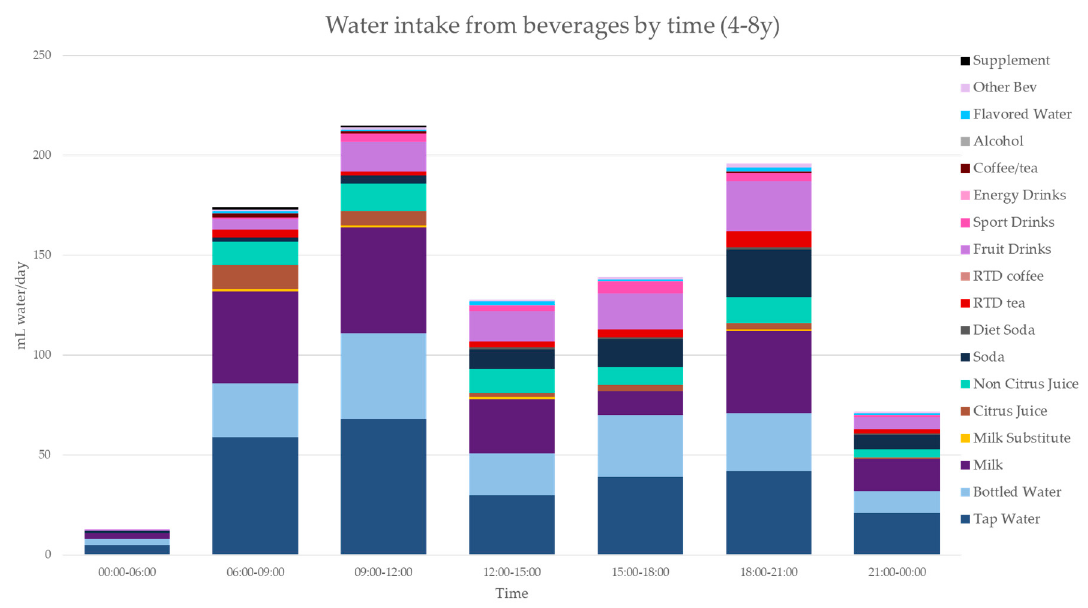
Figure 3. Water intakes (mL / d) by beverage type and time of day for the 4–8 y age group (NHANES 2011–2016).